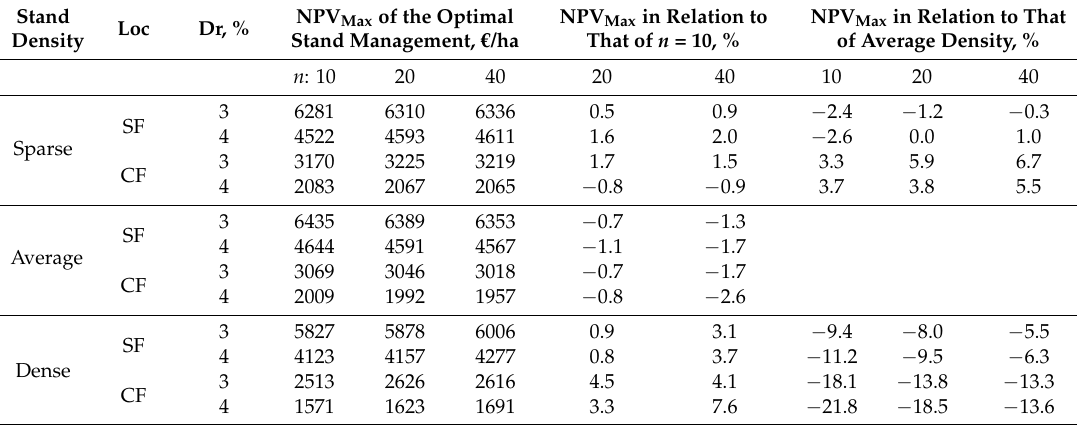
Table 1. The maximum net present value, NPV Max ( € /ha) associated with the optimal solutions. The comparisons are made in relation to (i) the NPV Max of the 10-tree sample and (ii) in relation to that of the average stand density. The location (Loc) was in southern Finland (SF) or central Finland (CF) having a temperature sum of 1250 and 1050 ◦ C degree days, d.d., respectively. The discount rate (Dr) is expressed in